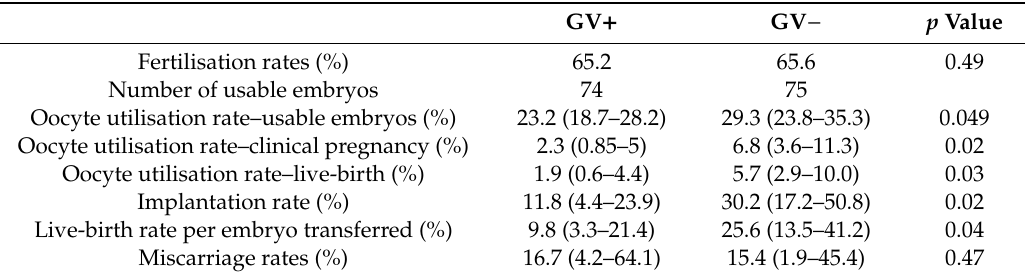
Table 4. Clinical outcomes.